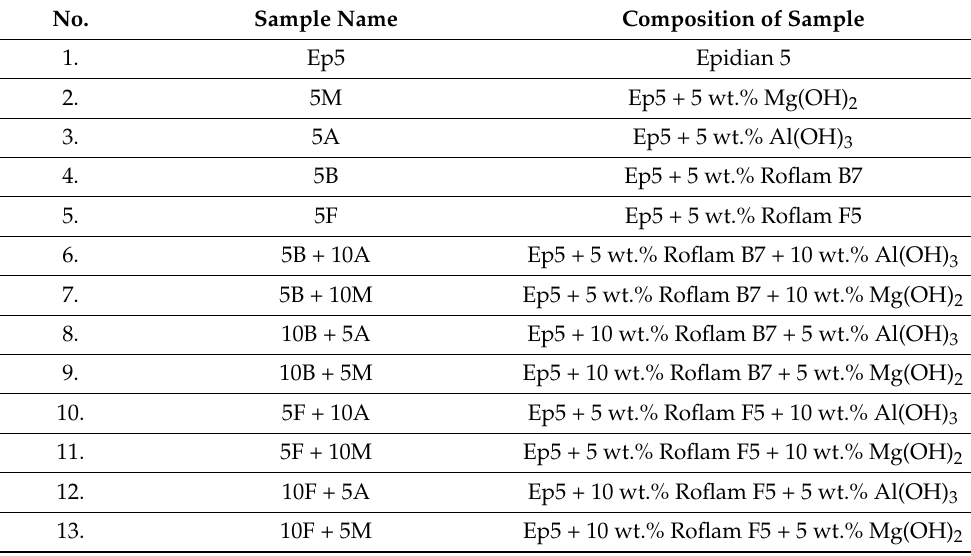
Table 2. Composition and marking of analyzed